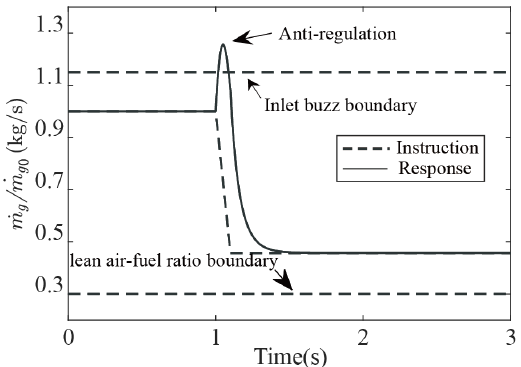
Figure 4. Anti-regulation of the gas flow and the security boundaries.